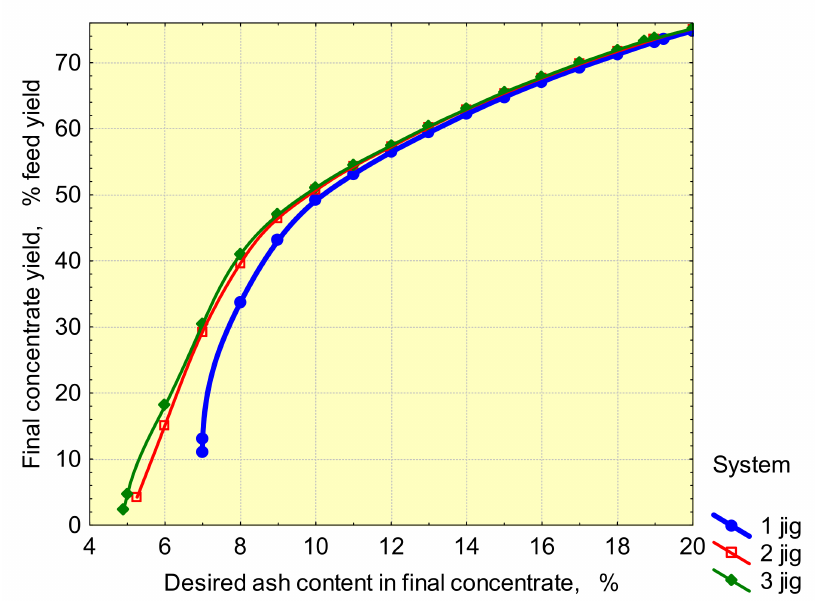
Figure 10. Maximum values of the yield of final concentrates at different set ash contents in these